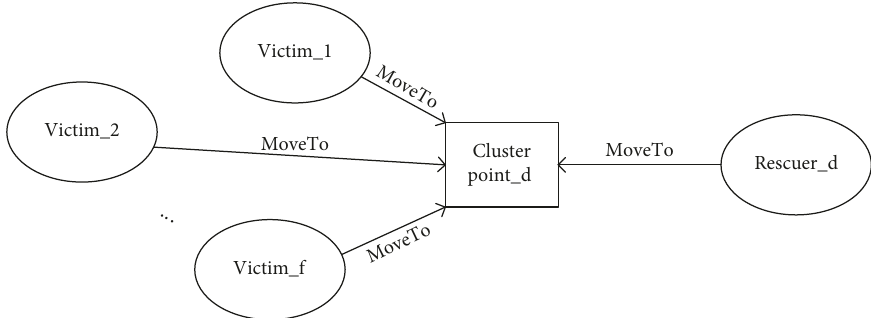
Figure 4: Victims and rescuers move to the cluster point